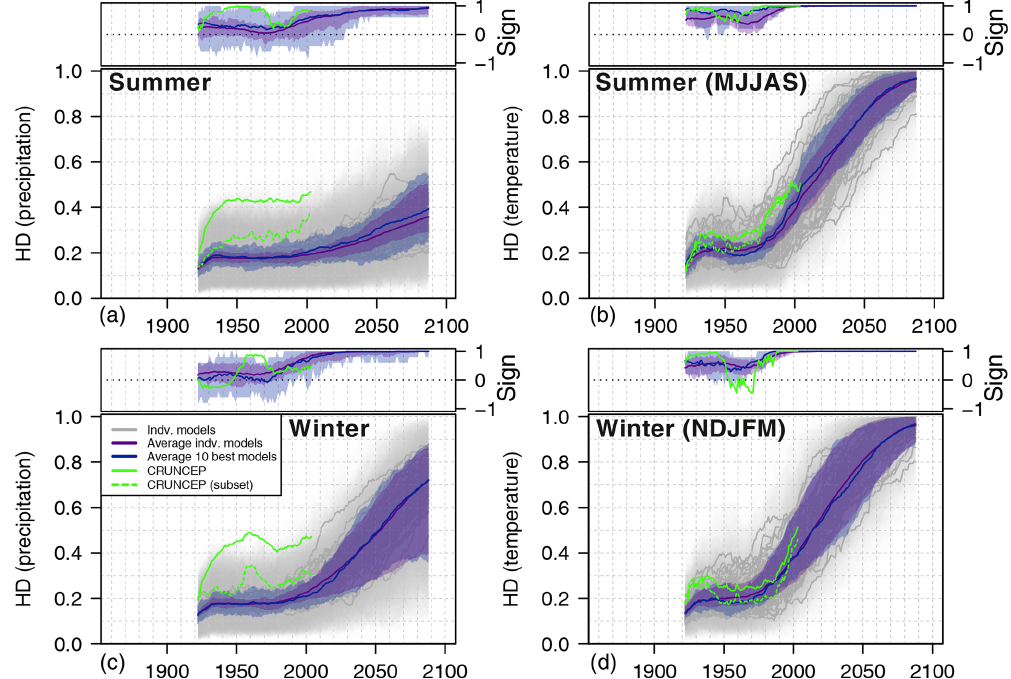
Figure 7. Summer (May–September) (a, b) and winter (November–March) (c, d) emergence as the Hellinger distance (HD) and the sign of emergence. Shading indicates the value range over all pixels in the study area. Dashed line for CRUNCEP shows HD evolution based only on the five pixels where meteorological stations cover more than 10 years in the reference period to eliminate data issues.